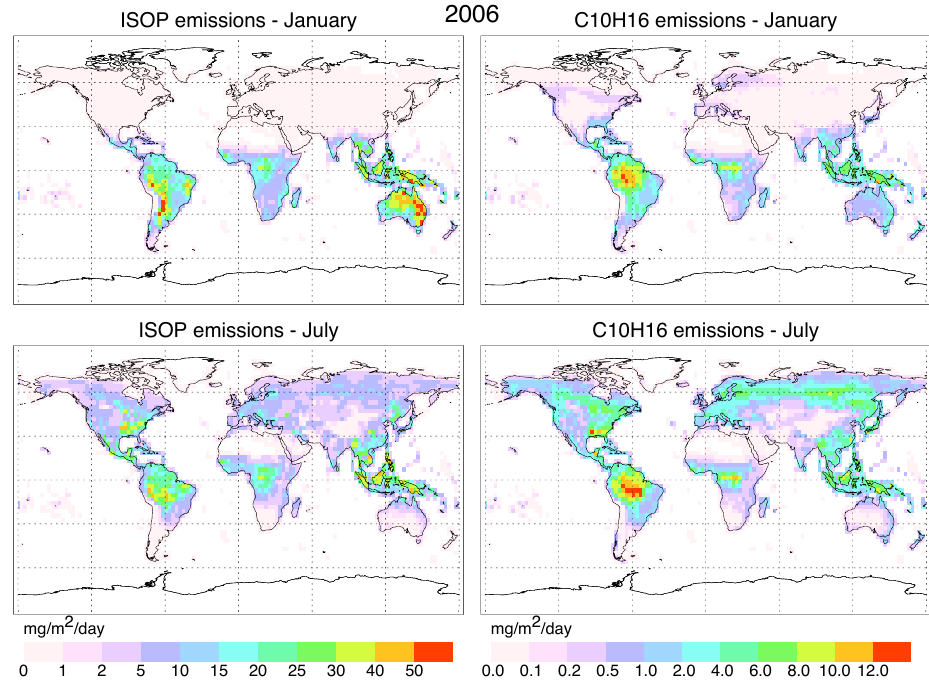
Fig. 1. Emissions of isoprene and monoterpenes for January and July 2006, from online calculation by MEGAN in MOZART-4.